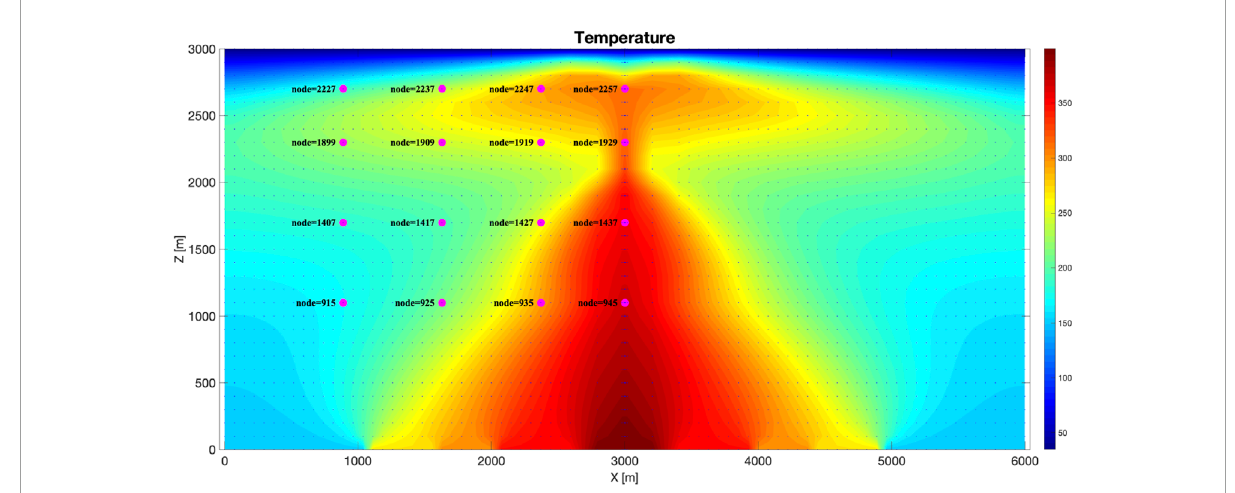
FIGURE 7 Temperature field in the Phlegraean Fields. Results of the analysis ( t fin ) .